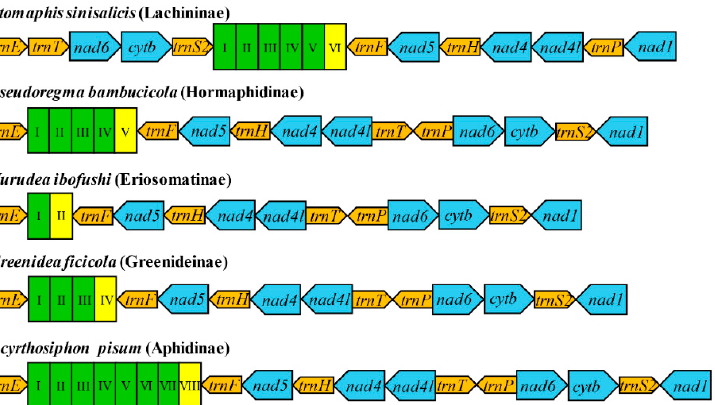
Figure 7. Repeat regions of the mitochondrial genome from Stomaphis sinisalicis and selected repre- sentative species from other aphid subfamilies. Green bars indicate tandem repeats, and the yellow bars refer to partial repeat unit; PCGs and tRNAs are indicated by the turquoise and orange squares, respectively.